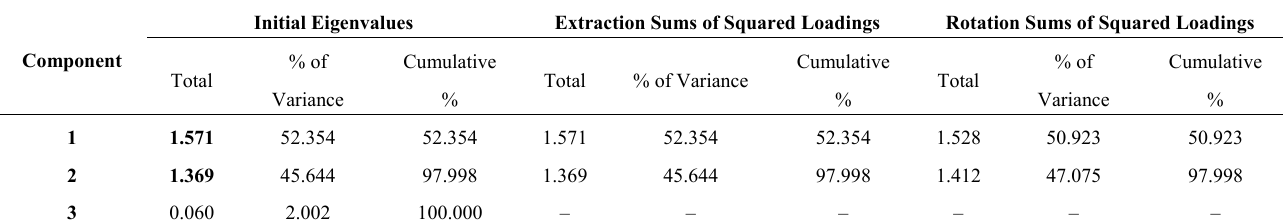
Table 6. Total variance explained.